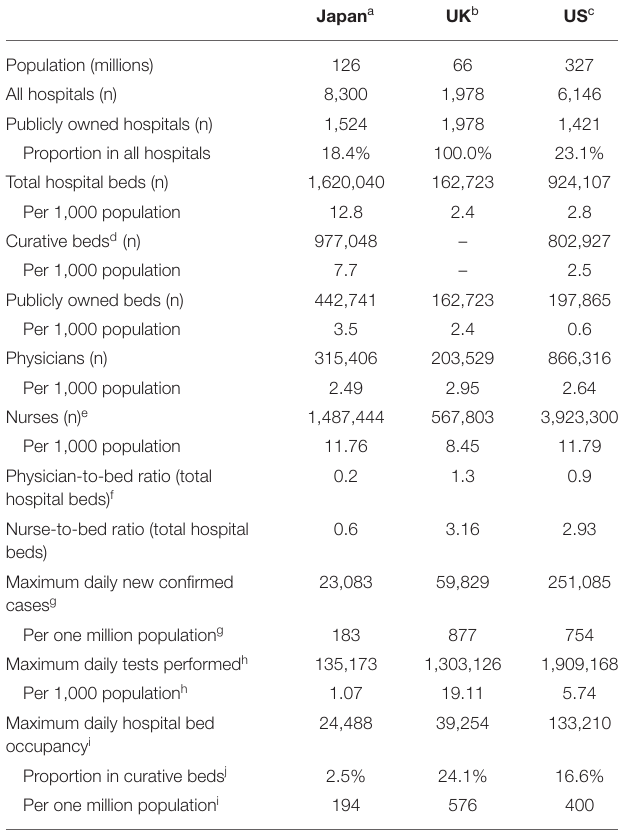
TABLE 1 | Hospitals, hospital beds, COVID-19 patients, and bed occupancies in Japan, the UK, and the